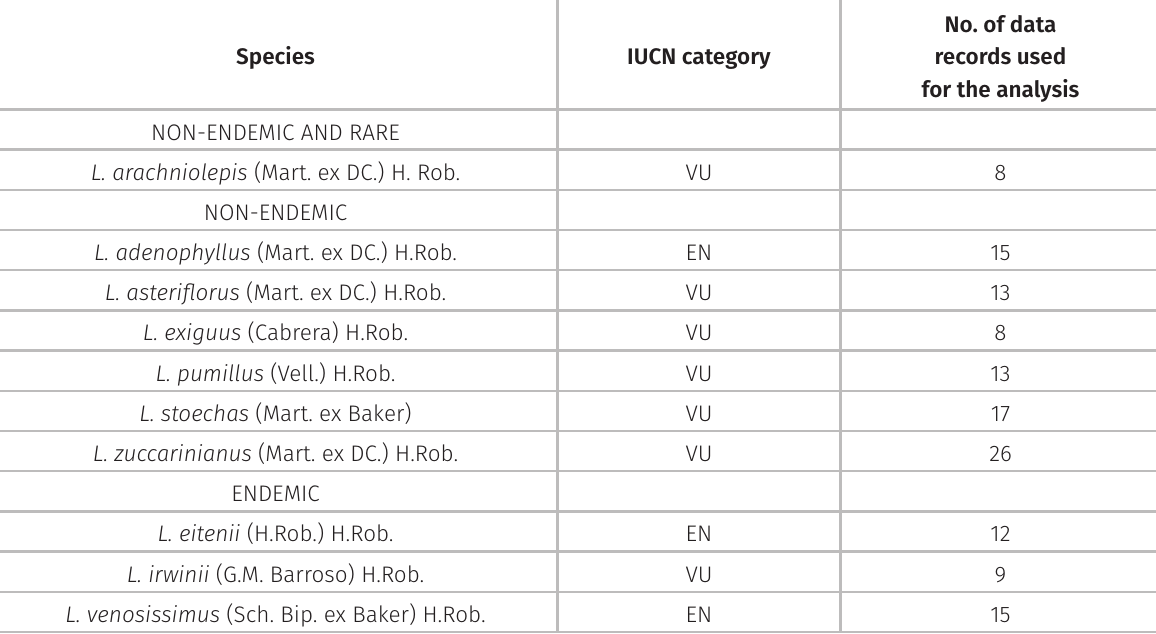
Table I. Species , IUCN category: VU: vulnerable, EN: endangered (according to Martinelli & Moraes 2013, Martinelli et al. 2014) and number of data records of Lessingianthus species